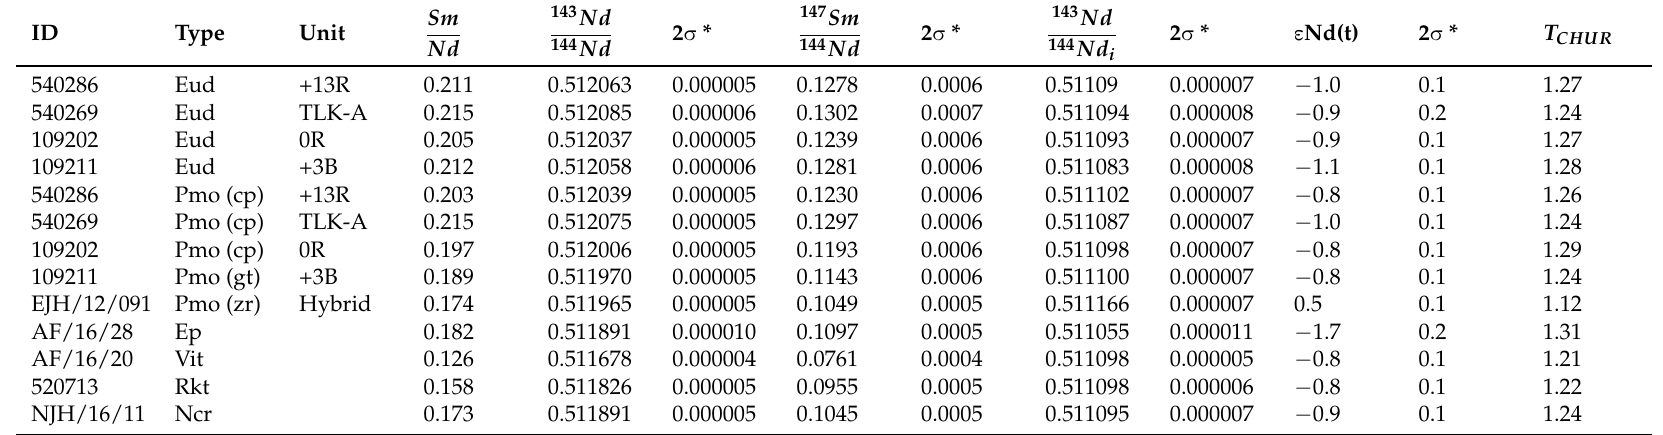
Table 4. Isotope data of eudialyte, eudialyte pseudomorphs and rare earth minerals. Initial ratios calculated for an intrusion age of 1160 Ma using a decay constant for 147 Sm of 6.54 × 1012 [52] and a relative standard deviation on Sm/Nd of 0.005 that was estimated based on repeated measurements of geological standards. Calculation of ε Nd(t) and T using a present day CHUR 143 Nd/ 144 Nd ratio of 0.512638 [53] and a 147 Sm/ 144 Nd of 0.1966 [54]. Decay constant and age of CHUR